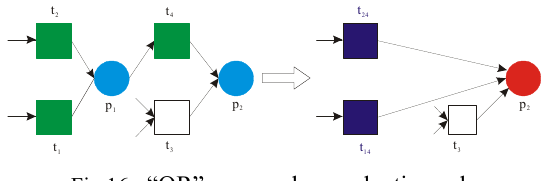
Fig 16. “OR” merge place reduction rule